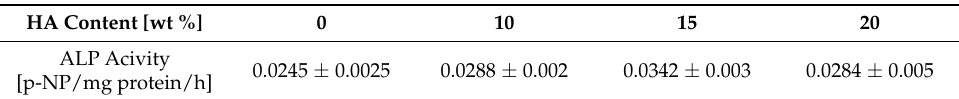
Table 2. Alkaline phosphatase (ALP) activity of the MC3T3-E1 cells that were cultured for 7 days on the macro/micro-porous PCL/HA composite scaffolds (HA content = 0 wt %, 10 wt %, 15 wt %, and 20 wt %) using a basal